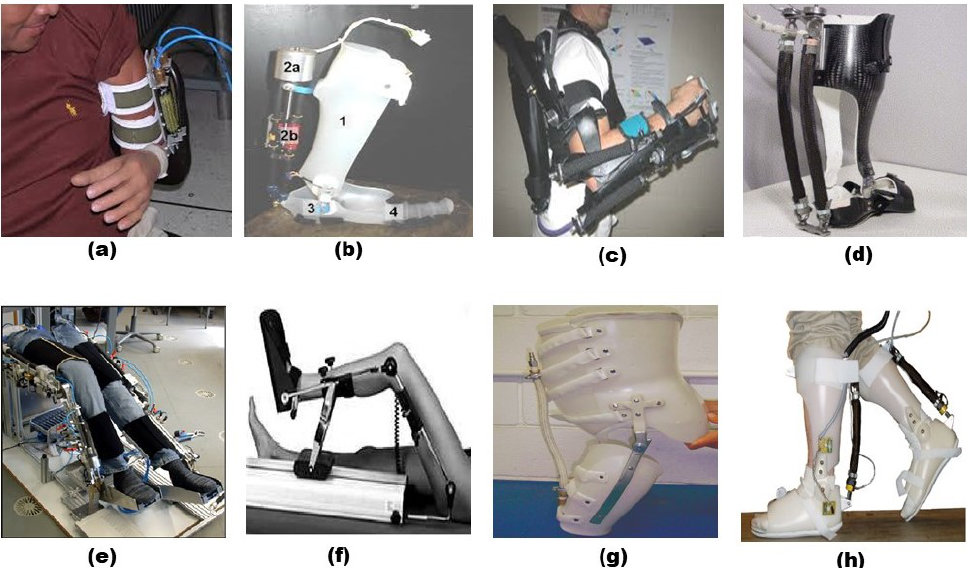
Figure 13. Medical applications of PAMs: ( a ) PAM-actuated forearm [143]; ( b ) Powered ankle–foot orthosis [145]; ( c ) RUPERT [146,147]; ( d ) Powered ankle–foot orthosis [149–151]; ( e ) Orthosis for home training [153]; ( f ) Isokinetic equipment [154]; ( g ) Hip exoskeleton [156]; ( h ) PAFO